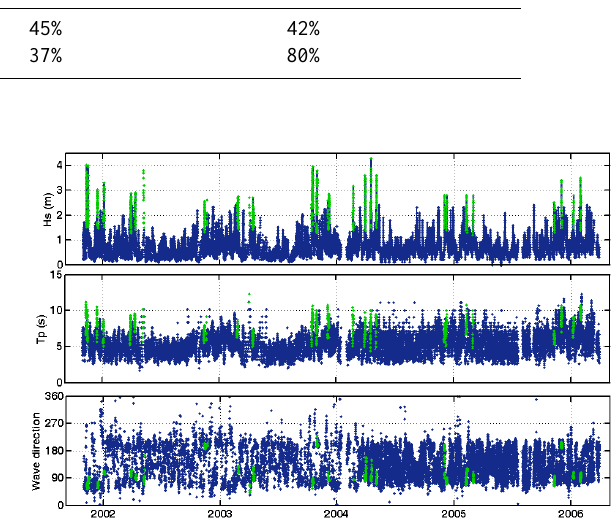
Figure 2. Deep-water wave conditions off Barcelona from November 2001 to March 2006 (from top to bottom, significant wave height, peak period, and approaching wave direction). Green dots indicate the major 25 storms analyzed. Storm conditions are predominantly from the East.